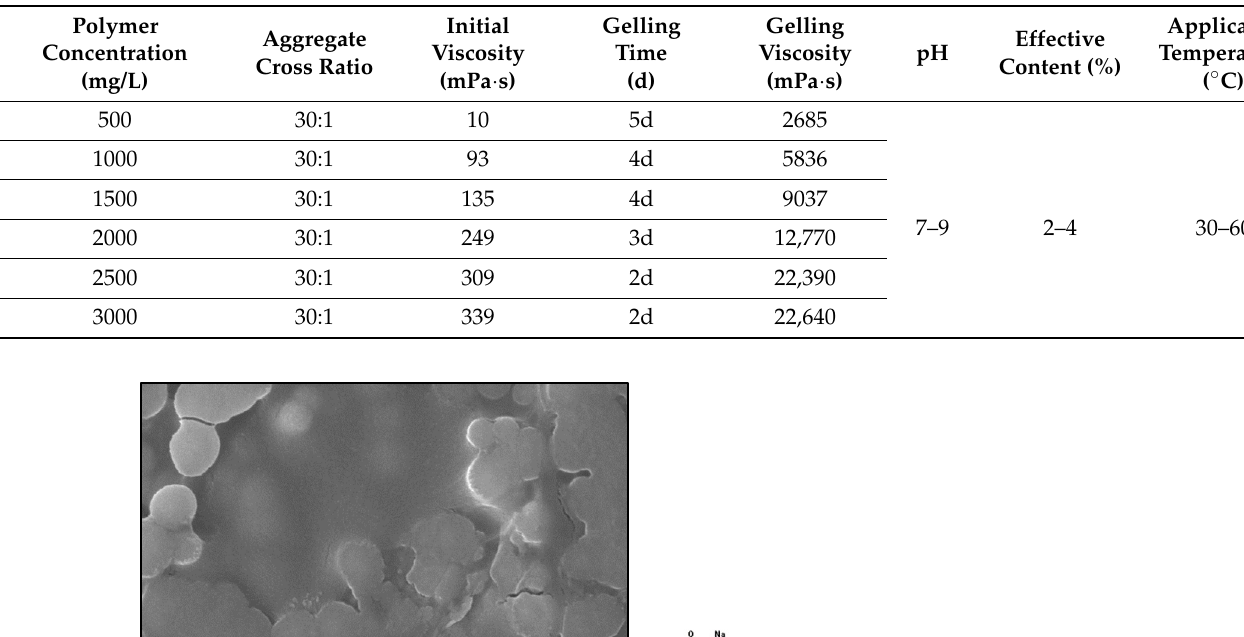
9 of 16 Table 7. Crosslinking agent performance evaluation test result table. Polymer Con- centration